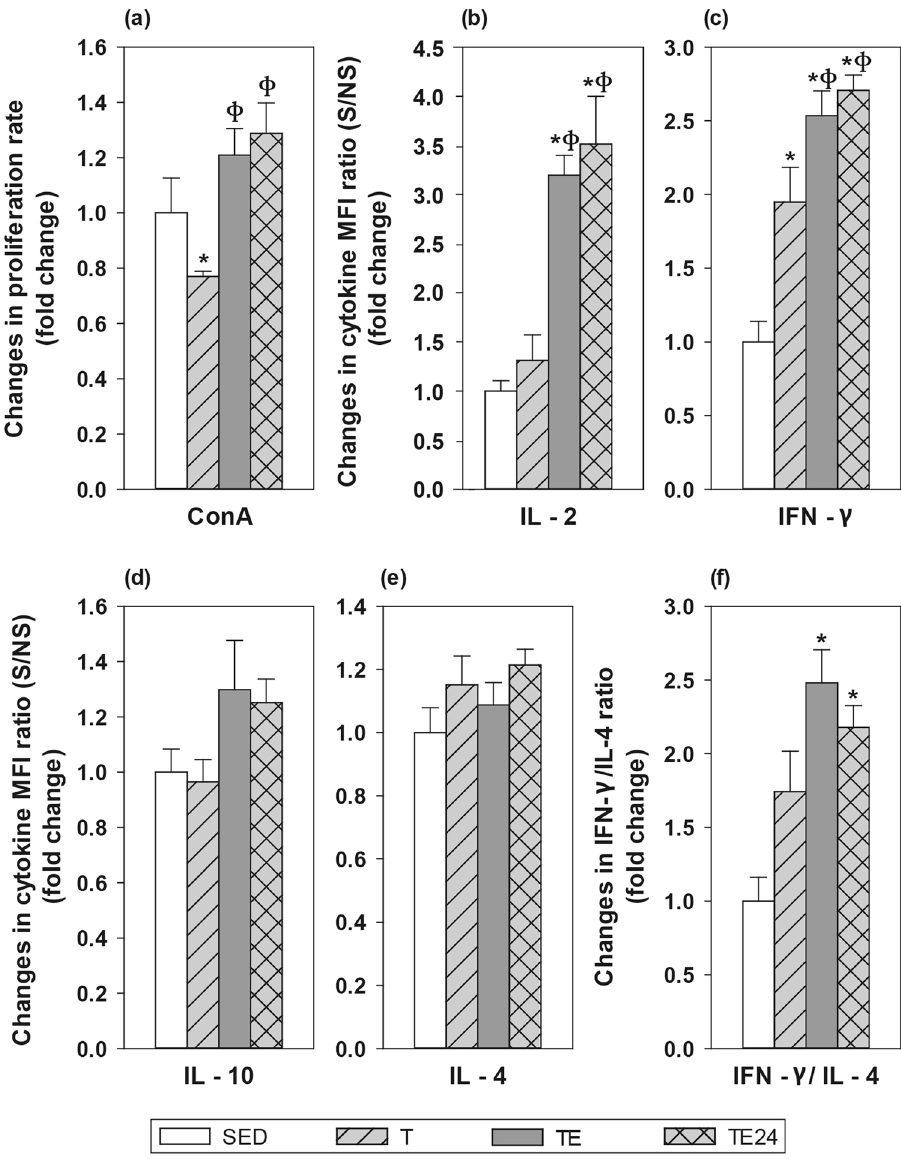
Figure 6. Changes in the proliferative response ( a ) and cytokine concentration released ( b – f ) by mesenteric lymph node lymphocyte stimulated by concanavalin A (ConA) compared to the sedentary group. SED sedentary rats, T trained rats, TE T rats with a final exhaustion test, TE24 TE rats 24 h after the final exhaustion test. Data are expressed as mean ± standard error (n = 8). Statistical differences (one-way ANOVA followed by post-hoc Tukey test for b , d , and Kruskal–Wallis followed by Mann–Whitney U test for a , c , e ): *p < 0.05 vs SED group; ф p < 0.05 vs T